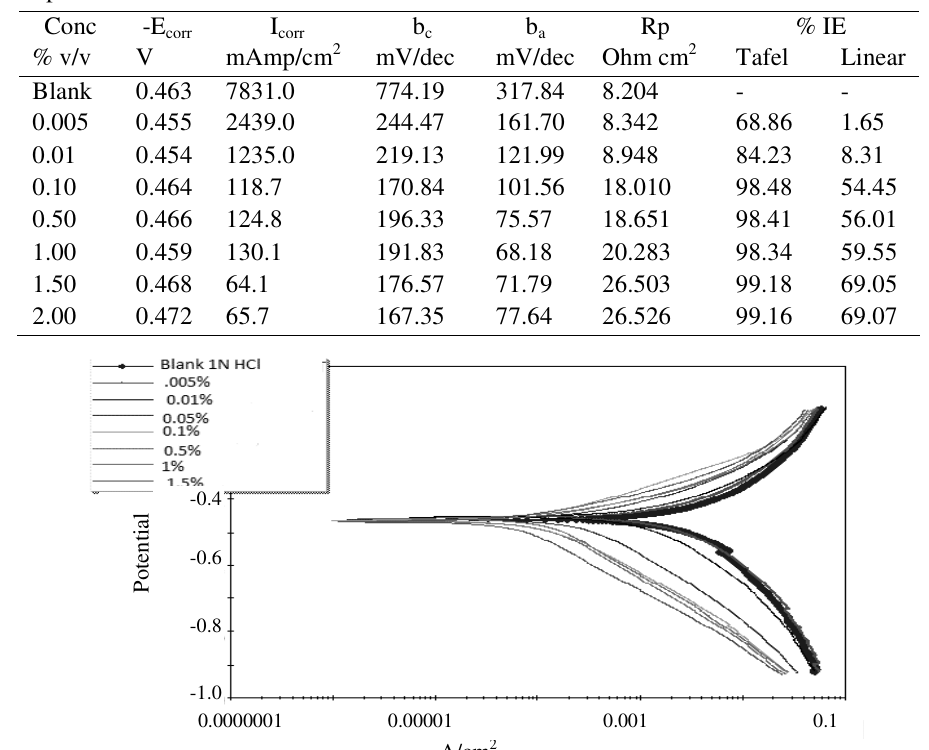
Figure 6. Potentiodynamic polarization curves for mild steel in 1 N HCl without and with different concentrations of MNP